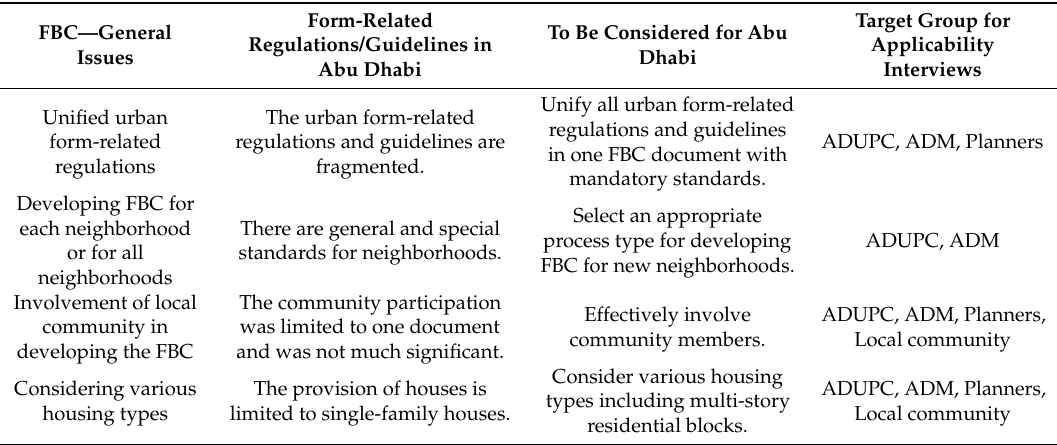
Table 4. Target groups for interviews about the applicability of the proposed localized FBC for new urban neighborhoods in Abu